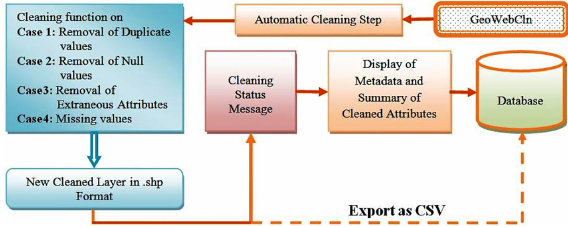
Fig. 3. Data cleaning process using GeoWebCln tool.